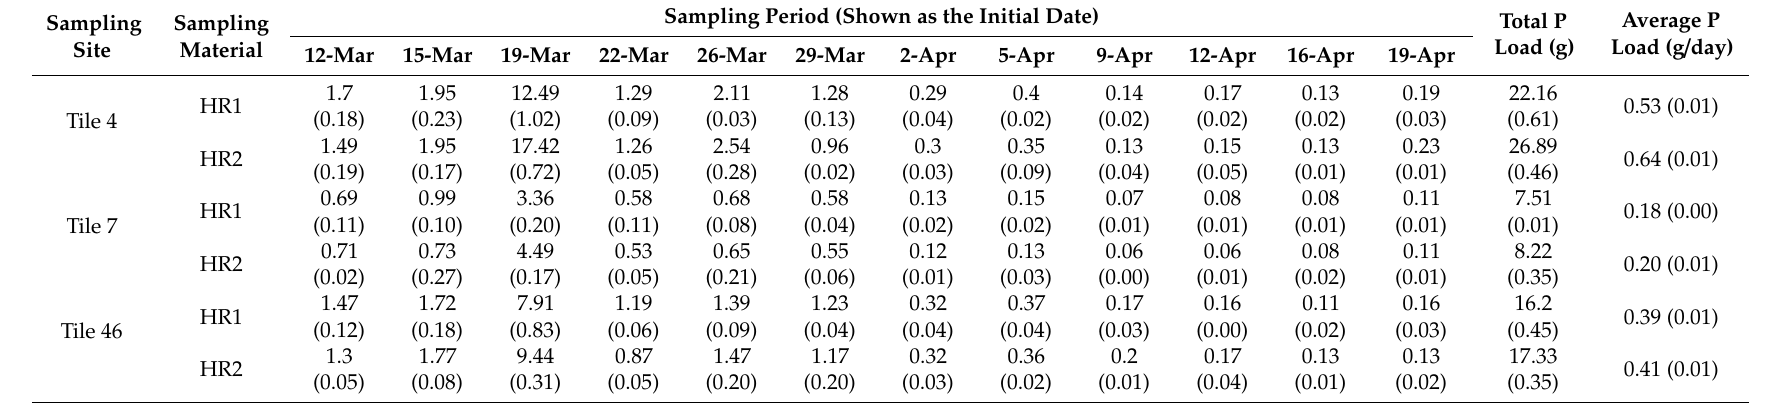
Table 8. Load of P (unit: g / period) discharged through each tile line in each sampling period calculated from flow volumes and DRP concentrations based on HR1- and HR2-sampling. The period refers to 3–4 days of deployment period of the resin bags. Standard deviations are shown in parentheses.